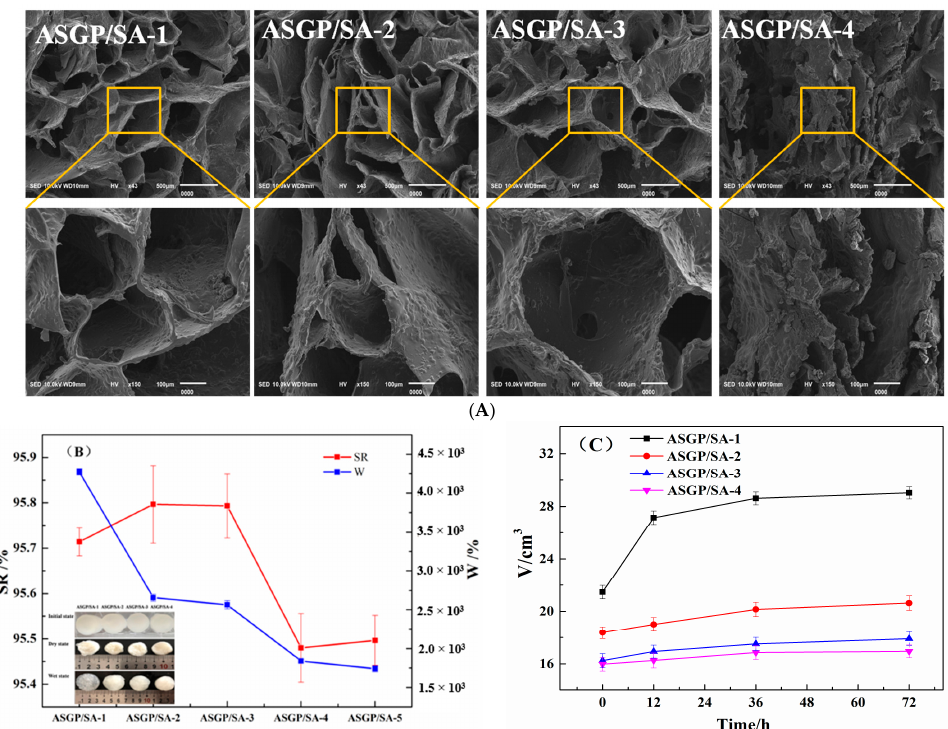
Figure 2. ( A ) SEM; ( B ) the swelling ratio (SR), water absorption (W), and the initial/Dry/Wet; states and ( C ) stability of drug loaded